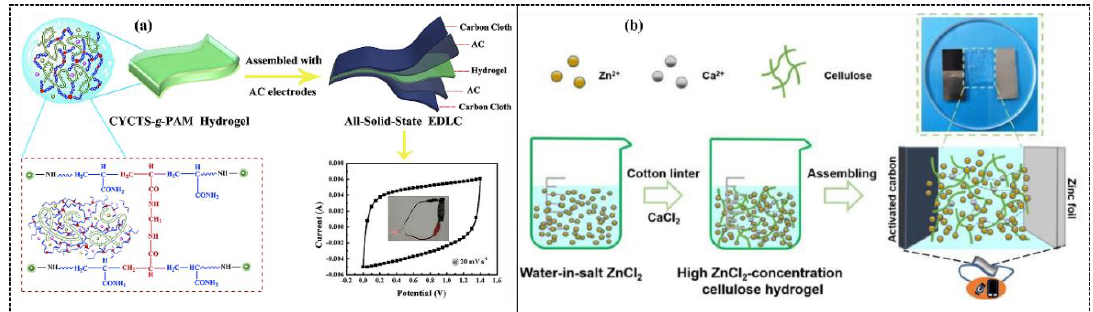
Figure 18. ( a ) Synthesis and supercapacitor assembly containing prepared covalently carboxylated chitosan hydrogel electrolytes [178]. ( b ) Synthesis of physically crosslinked cellulose hydrogel electrolytes and zinc ion hybrid supercapacitor assembly [180] .